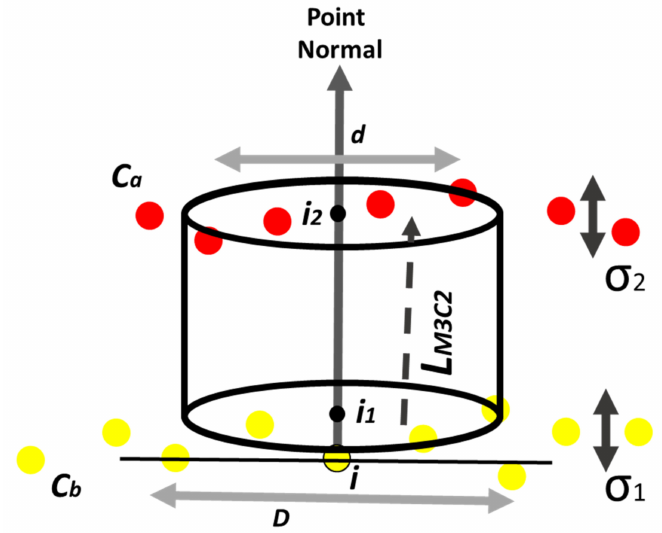
Figure 5. Cylinder projection distance M3C2 . The point normal for i is calculated using the scale, D . A cylinder with a diameter d and a user-specified maximum length is used to select points in Cb and Ca (point clouds to be compared) for the calculation of i 1 and i 2 , respectively. L M3C2 is the distance between i 1 and i 2 and is stored as an attribute of i . The local and apparent roughness of Cb and Ca are calculated as σ 1 and σ 2 , respectively, which are used to calculate the confidence interval of the spatial variable i [31,32].